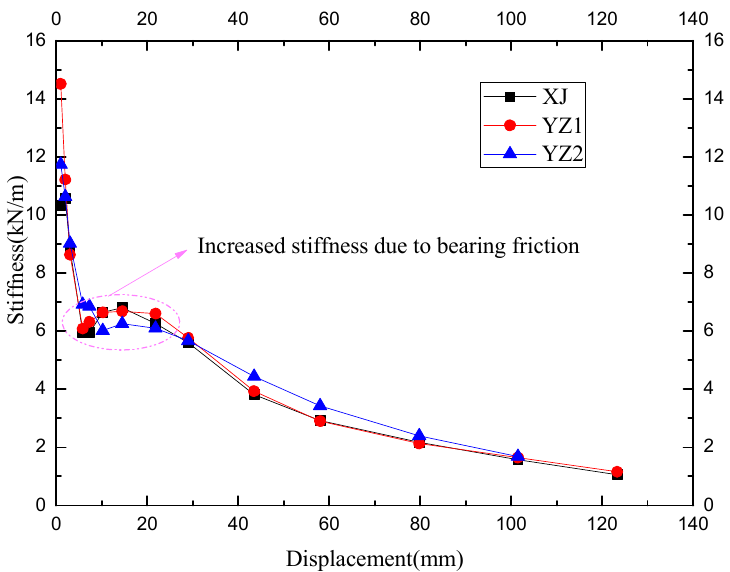
Figure 12. The stiffness degradation.